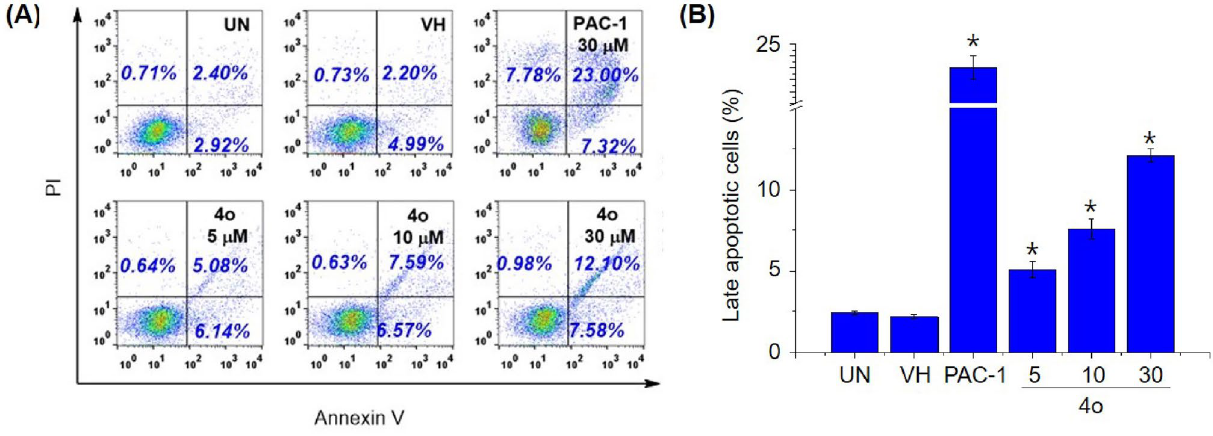
Figure 6. Apoptosis (Annexin V/PI) analysis of cells after treatment with different concentrations of compound 4o . U937 cells were treated with compound 4o at 5, 10 and 30 µM or PAC-1 (30 µM) for 24 h. The harvested cells were incubated with Annexin V-FITC and PI and analyzed by using flow cytometry. Ten thousand cells were acquired (n = 3). UN untreated, VH vehicle (DMSO. 0.1%). Representative dot plots ( A ). Live cells, left down in dot plot. Early apoptotic cells, right down. Necrotic cells, left up, Late apoptotic cells, right up. Bar graph of late apoptotic cells ( B ). p values were calculated using one-way ANOVA in GraphPad Software (San Diego, CA, USA). * p < 0.01 vs VH